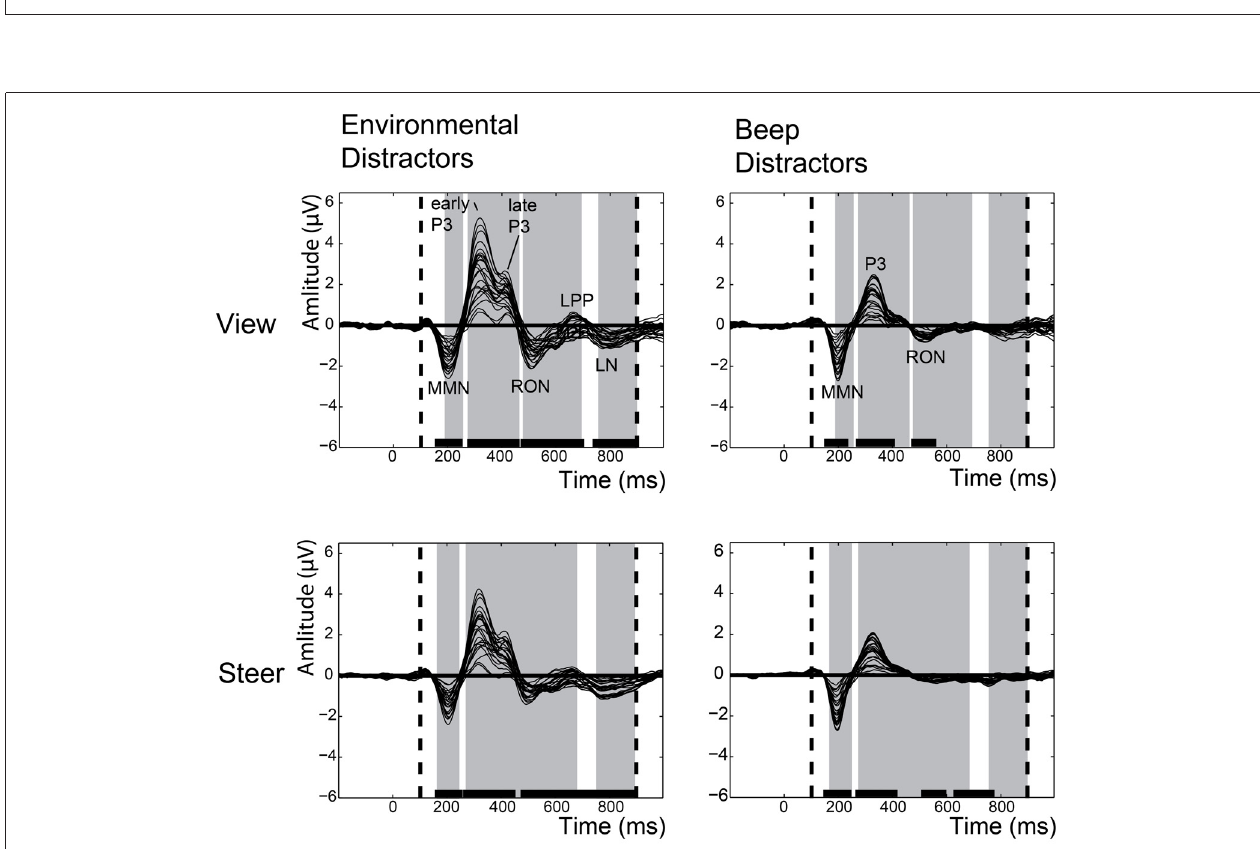
FIGURE 3 | Grand averaged waveform of the event-related potentials (ERPs) that were elicited by the environmental distractors (left column) and the beep distractors (right column), separately for the viewing (top row) and steering (bottom row). The grand averaged waveform shows the difference wave between the ERPs elicited by the environmental/beep distractors and the standard beep-tones. Every line represents one electrode. The dashed vertical lines represent the time window of interest (100–900 ms). The black bars specify the time range when the ERP amplitudes were significantly different from the pre-stimulus time-interval. The gray areas highlight the time-periods where the ERPs of the beep and environmental distractor differed significantly from each other.